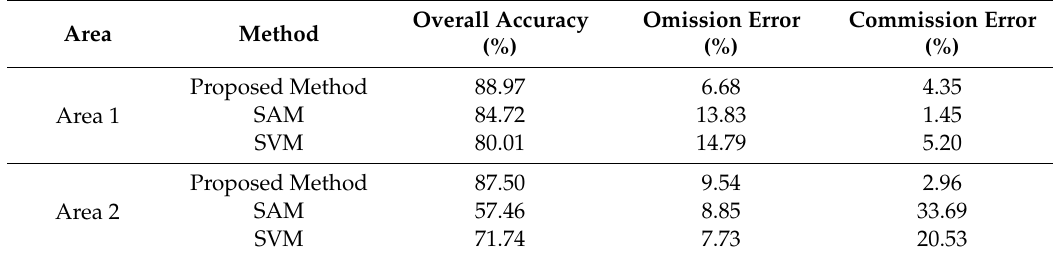
Table 4. Comparison of the different methods.